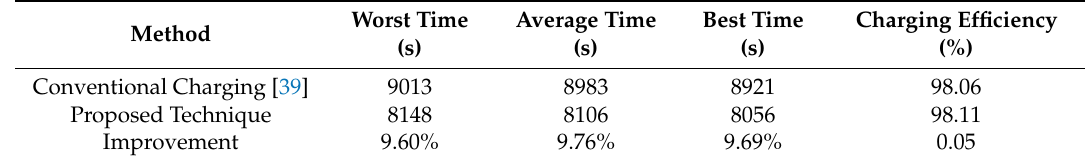
Table 2. Comparison of the charging